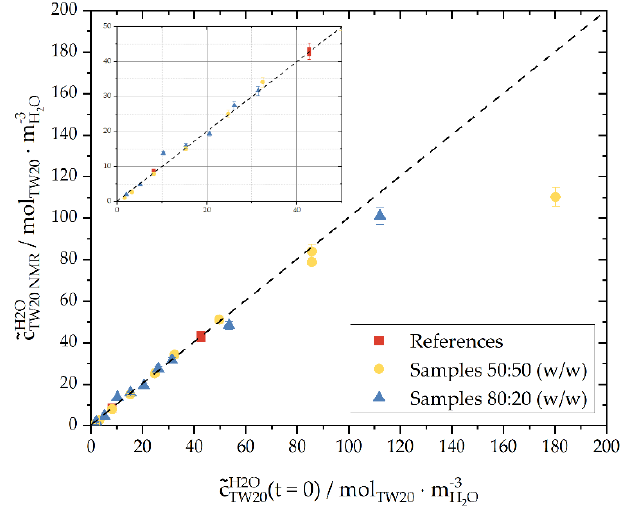
Figure 8. The concentration of Tween ® 20 in the water phase determined via NMR spectra 𝑐̃ (cid:3021)(cid:3024)(cid:2870)(cid:2868),(cid:3015)(cid:3014)(cid:3019)(cid:3009)(cid:2870)(cid:3016) as a function of the concentration of the weighed-in components 𝑐̃ (cid:3021)(cid:3024)(cid:2870)(cid:2868)(cid:3009)(cid:2870)(cid:3016) (𝑡 = 0) of samples with a 50:50 or 80:20 mass ratio of the continuous phase to the dispersed phase (n-hexadecane). In addition, reference samples of Tween ® 20 in ultrapure water with defined concentrations are displayed (red). The samples were measured at 20 °C. Inset: Zoom-in to concentrations up to 𝑐̃ (cid:3021)(cid:3024)(cid:2870)(cid:2868)(cid:3009)(cid:2870)(cid:3016) (𝑡 = 0) = 50 mol · m − 3 . The relative measurement error of the spectrometer was 2%.